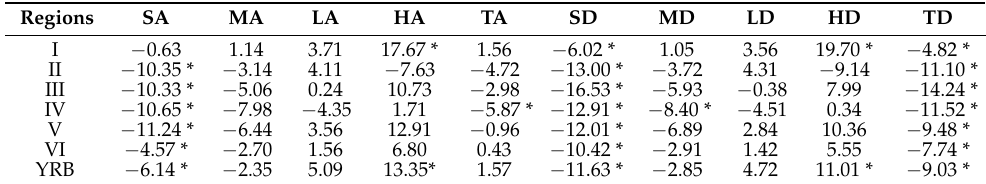
Table 4. Sensitivity of precipitation to the long-term trend of air temperature over the YRB and its six subregions from 1960–2017